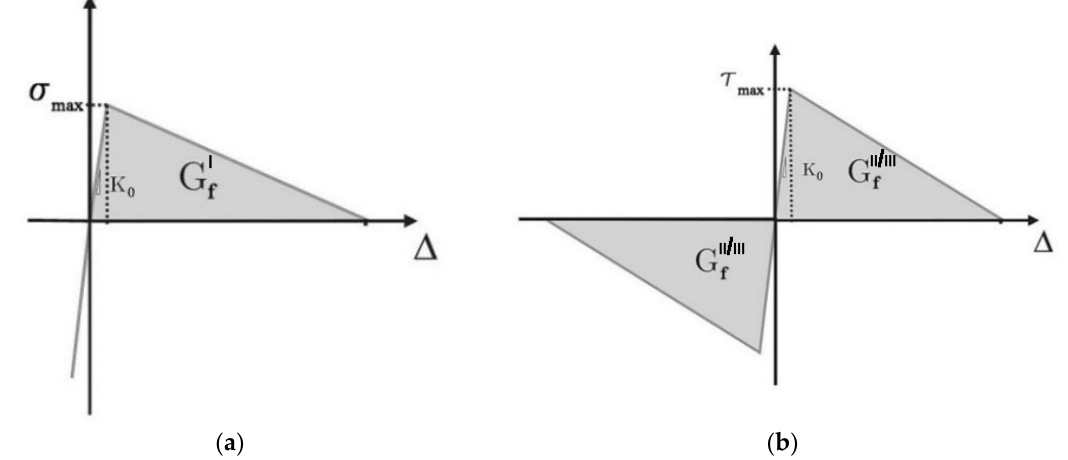
Figure 6. Traction-separation response: ( a ) mode I; ( b ) modes II and III.